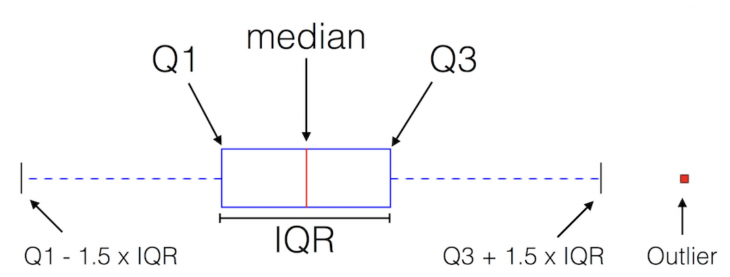
Figure 4: Boxplot illustration from Sebastian Raschka [ 66 ] . The image has been cropped to remove explanatory text. Q1 denotes the first quartile i.e. the value below which is 25% of the data points. The median or Q2 divides the data points in half. Q3 indicates the values below which is 75% of the data points. The interquartile range IQR is the range between Q1 and Q3. Values that lie below Q1 − 1.5 × IQR and above Q1 + 1.5 × IQR are plotted separately as points and are referred to as